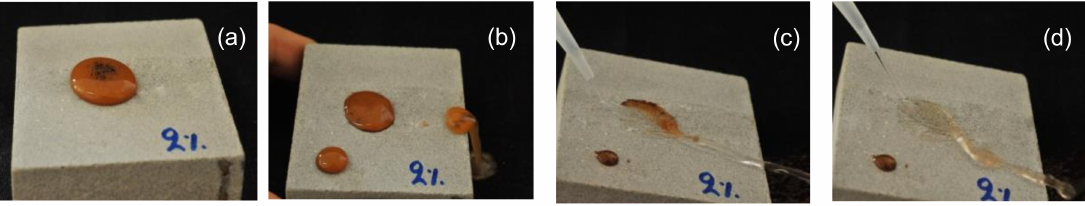
Figure 4. Demonstration of the easy/self-cleaning property of the Silres + nanoparticles coating on sandstone. Large drops of soiled water on the surface of coated sandstone ( a , b ) could be easily removed ( b ) and cleaned with fresh water ( c , d ).